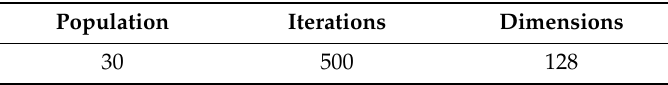
Table 10. Population, iterations, and